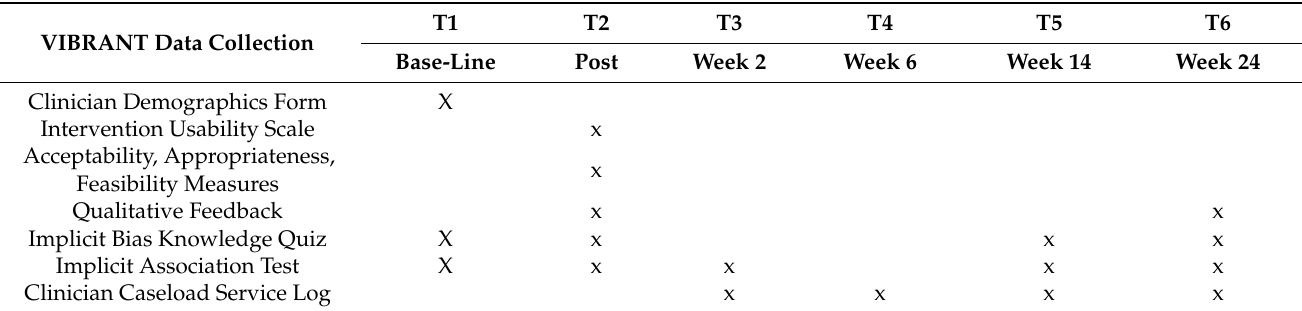
Table 1. Measure Administration